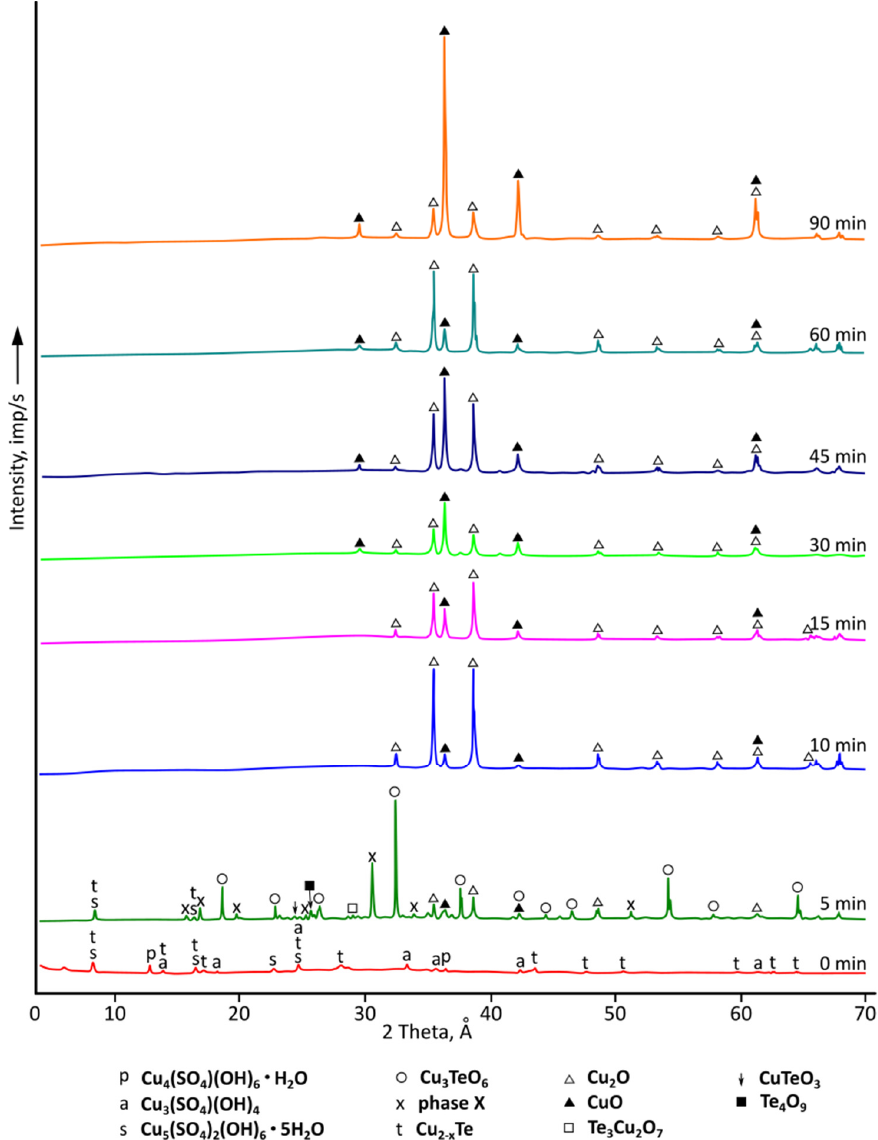
Figure 7. X-ray patterns of residues were obtained at 1000 °C, 0.67 kPa, and different roasting durations.